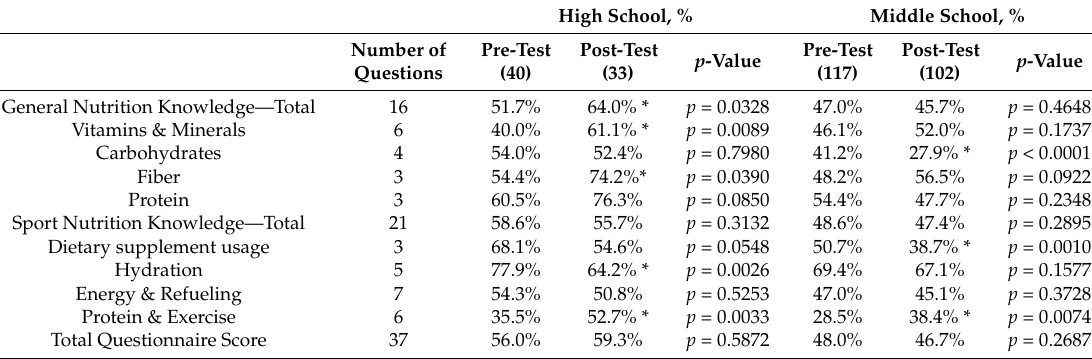
Table 7. General and sport nutrition knowledge pre- and post-test